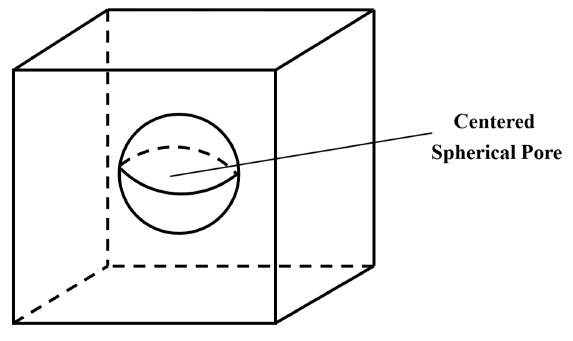
Figure 8. A simplified porous model for verifying our computational